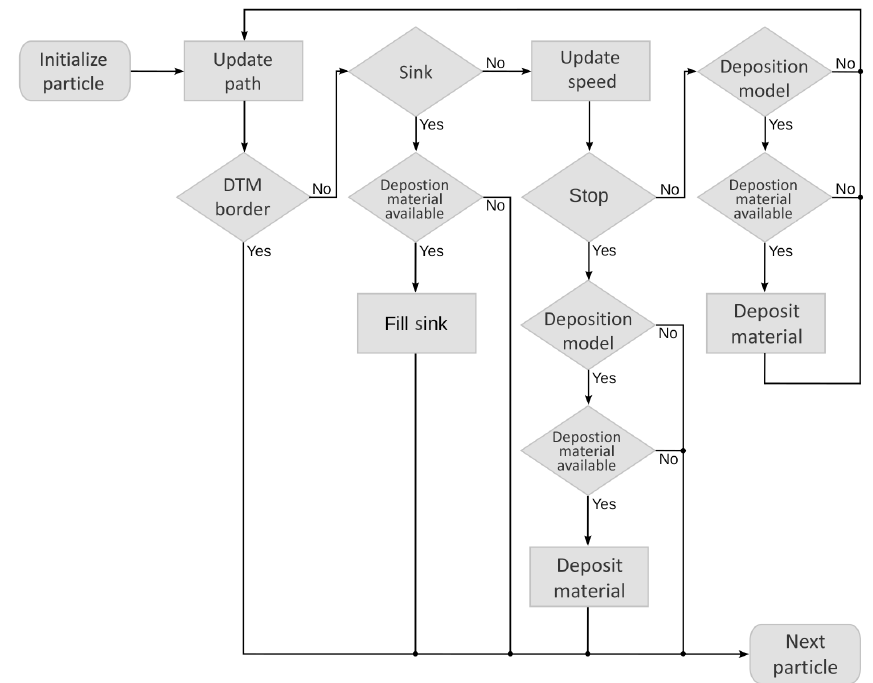
Figure 3. Flowchart of a fully featured GPP model configuration for scenario